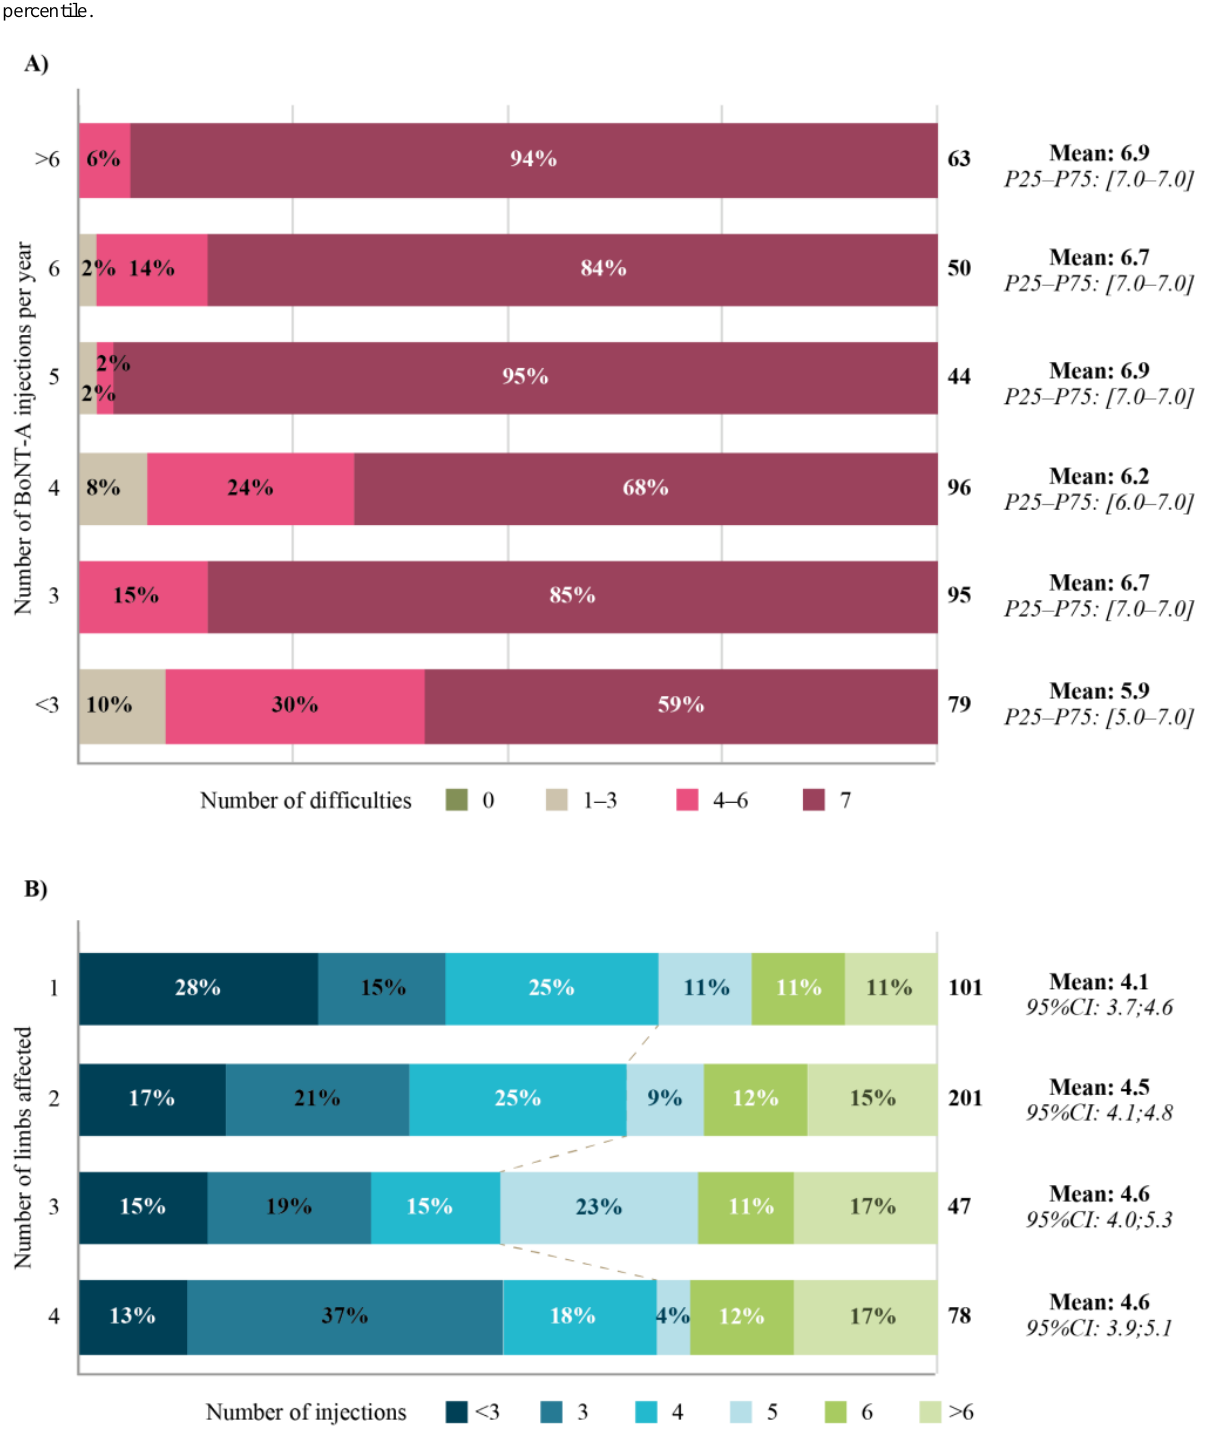
Figure 4. Patient responses to (A) the number of difficulties in activities of daily living, according to the number of botulinum neurotoxim type A (BoNT-A) injections received each year ["On average, how many BoNT-A treatments do you receive per year (numeric response)?" "For each of the following items, please assess the level of difficulty you experience due to your spasticity" (scale, 0=no difficulty and 10=severe difficulty)] and (B) the number of limbs affected according to the number of BoNT-A injections received each year ["In which (how many) limbs do you experience spasticity symptoms (multiple-choice response)?" "On average, how many BoNT-A treatments do you receive per year (numeric response)"](n=427). P =